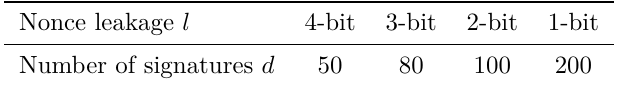
Table 2: Typical number of signatures for 160-bit